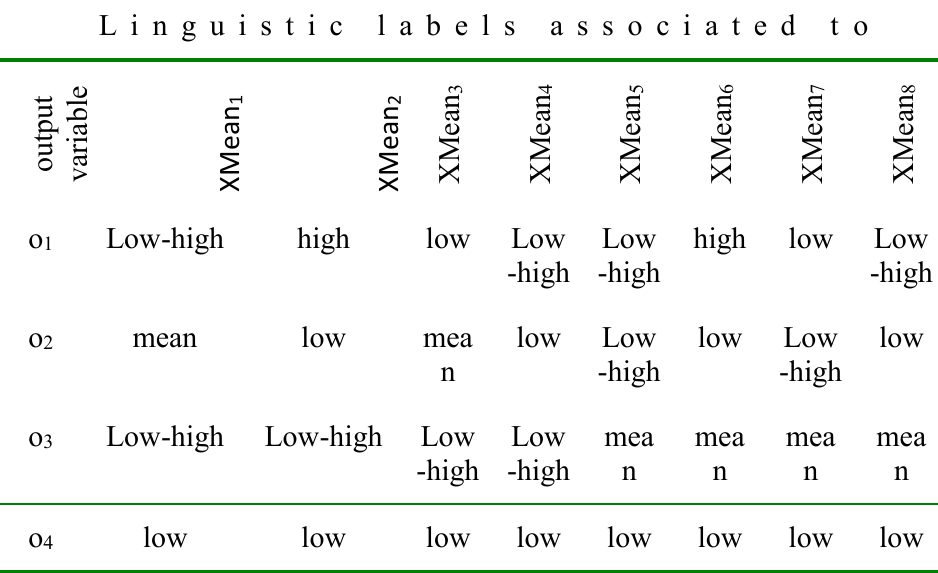
Table 8. Final linguistic labels for the output variables in the district